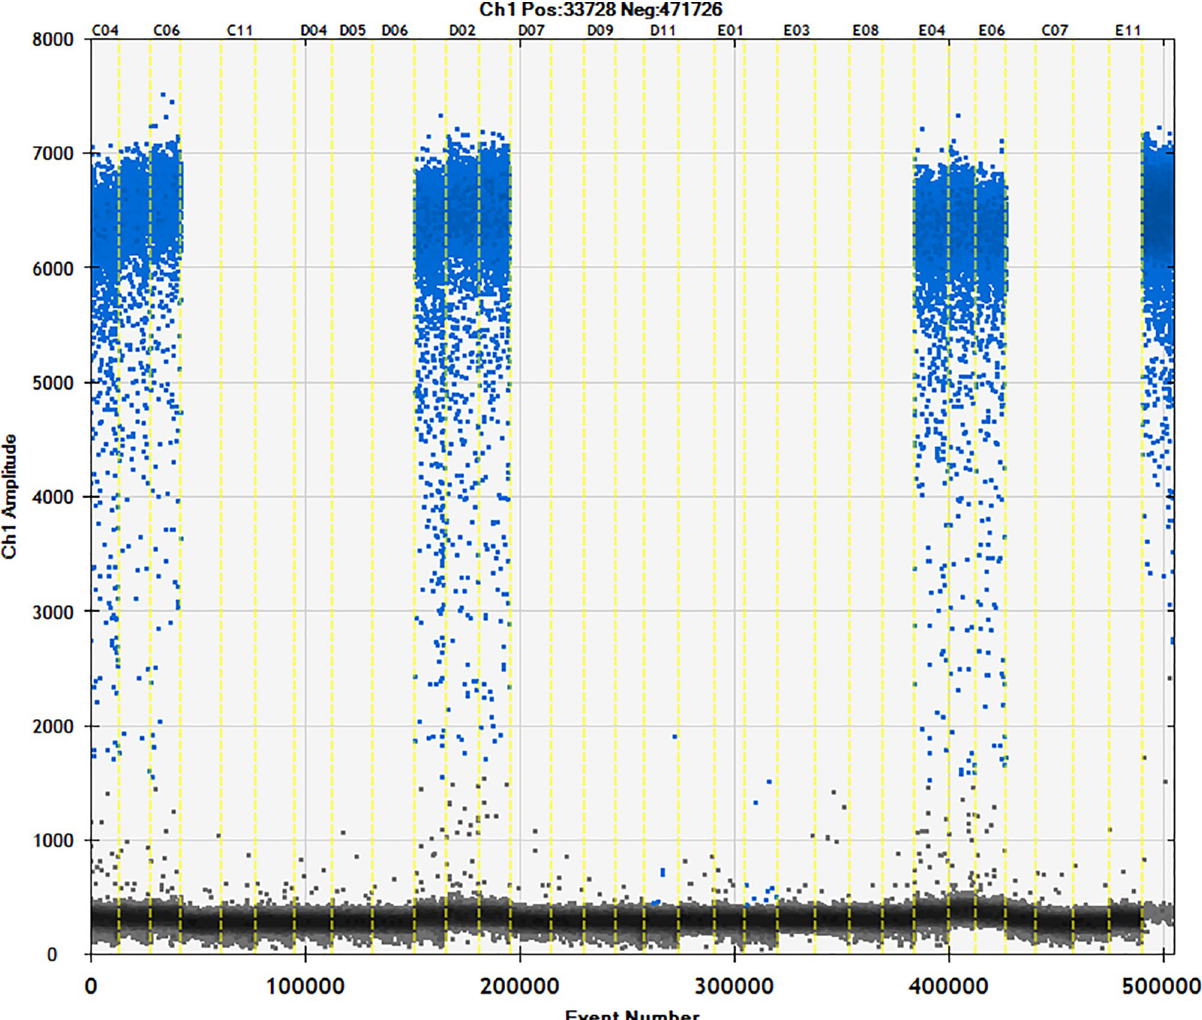
Fig 10. Actual test of commercially available samples. Channel 1–3: sample41; channel 4–6: sample42; channel 7–9: sample43; channel 10–12: sample44; channel 13–15: sample45; channel 16–18: sample46; channel 19–21: sample47; channel 22–24: sample48; channel 25–27: sample49; channel 28–30: sample50; channel31 negative; channel32